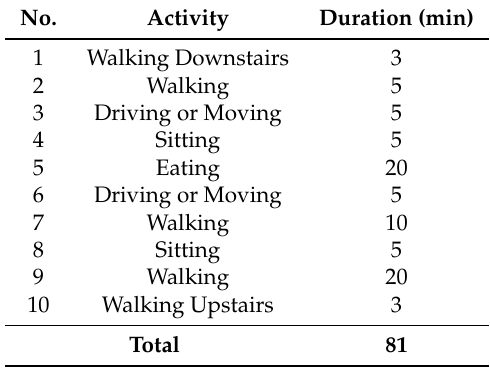
Table 2. Experiment protocol in the real-world scenario (two iterations).